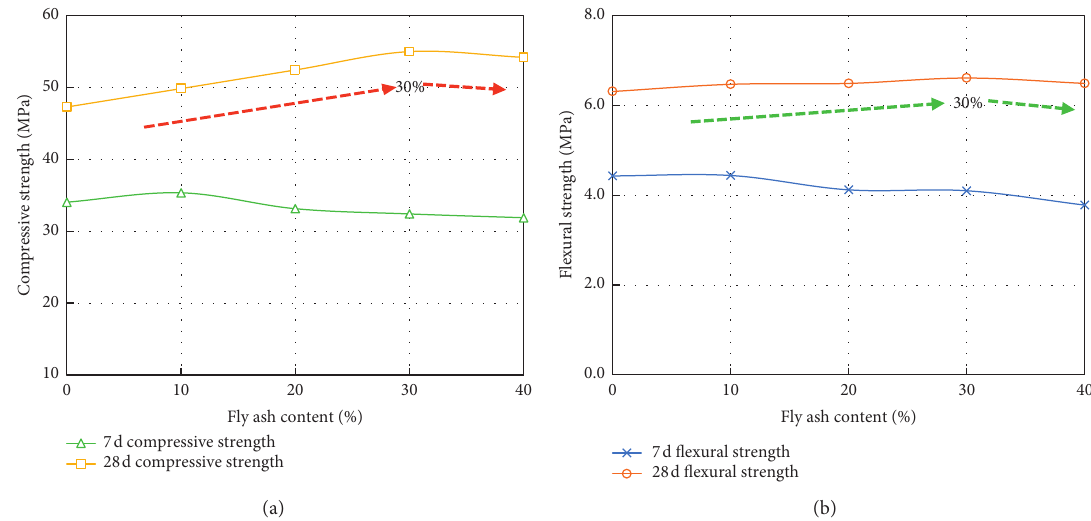
Figure 6: Strength of recycled aggregate concrete with different fly ash contents. (a) The compressive strength. (b) The flexural tensile